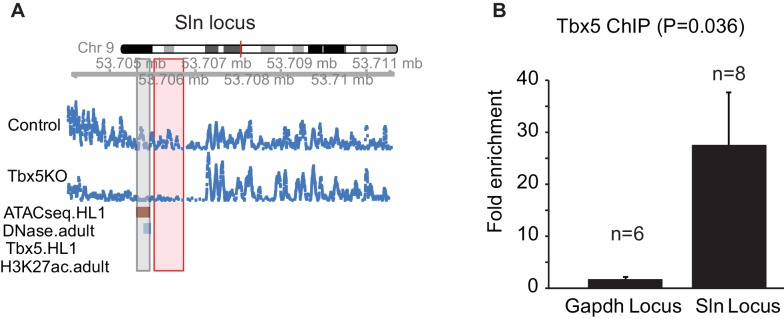
A TBX5-dependent enhancer at Sln that was not identified by TF ChIP-seq.(A) Genomic view of a Tbx5-activated ncRNA region adjacent to gene Sln. This locus shows significant Tbx5-dependence as determined by transcription expression in mouse atrium, open chromatin detected by ATAC-seq in HL1 cells, DHS signature in adult mice, but not by TBX5 occupancy or H3K27Ac in HL1 cells (GSE21529). (B) ChIP-qPCR of TBX5 comparing this Sln locus with the Gapdh locus. The Sln locus shows enrichment for TBX5 occupancy (n = 8, p=0.036). Two-sided t-test assuming unequal variances was performed.